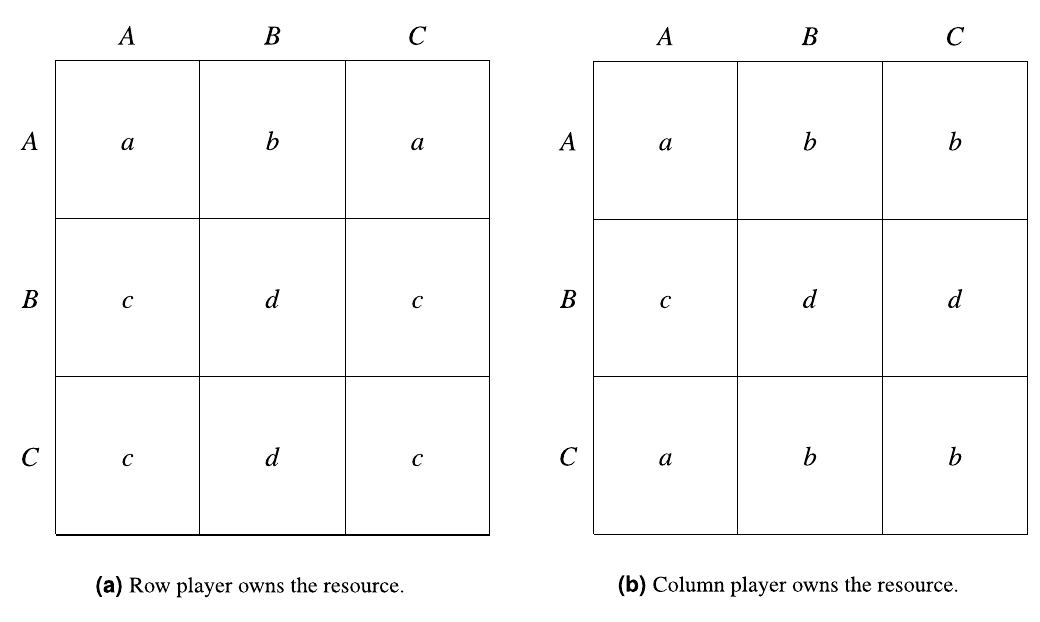
Figure 3. The Hawk–Dove–Bourgeois